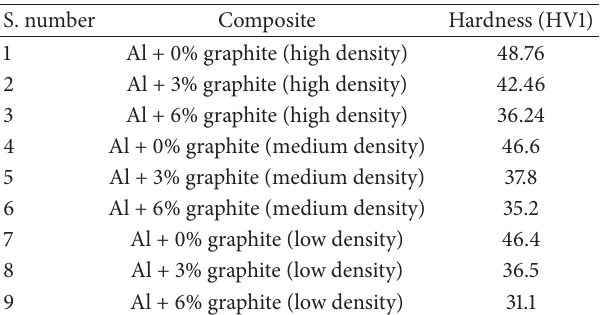
Table 4: Microhardness of the composites.